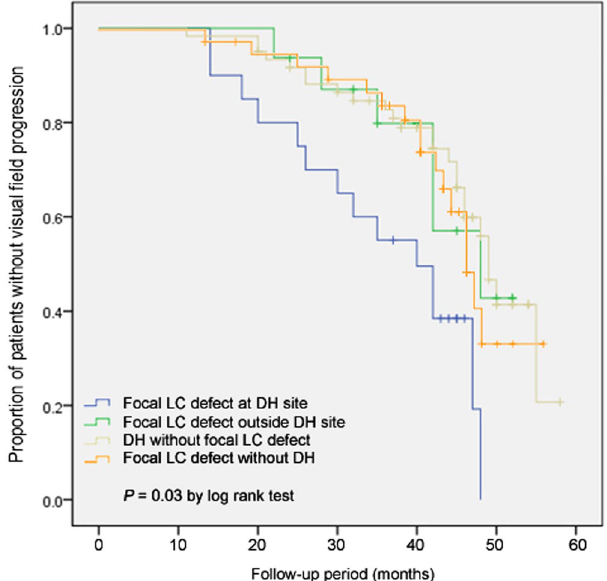
Figure 1. Kaplan-Meier survival curve for visual field progression in glaucoma eyes with disc hemorrhage according to the findings of the lamina cribrosa (LC) and eyes with focal LC defect without disc